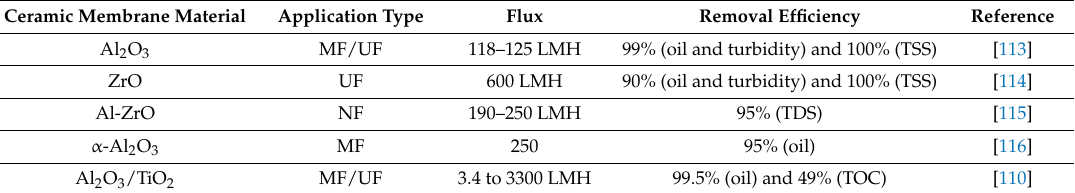
Table 3. Different studies on produced water (PW) treatment using various ceramic membranes. Ceramic Membrane Material Application Type